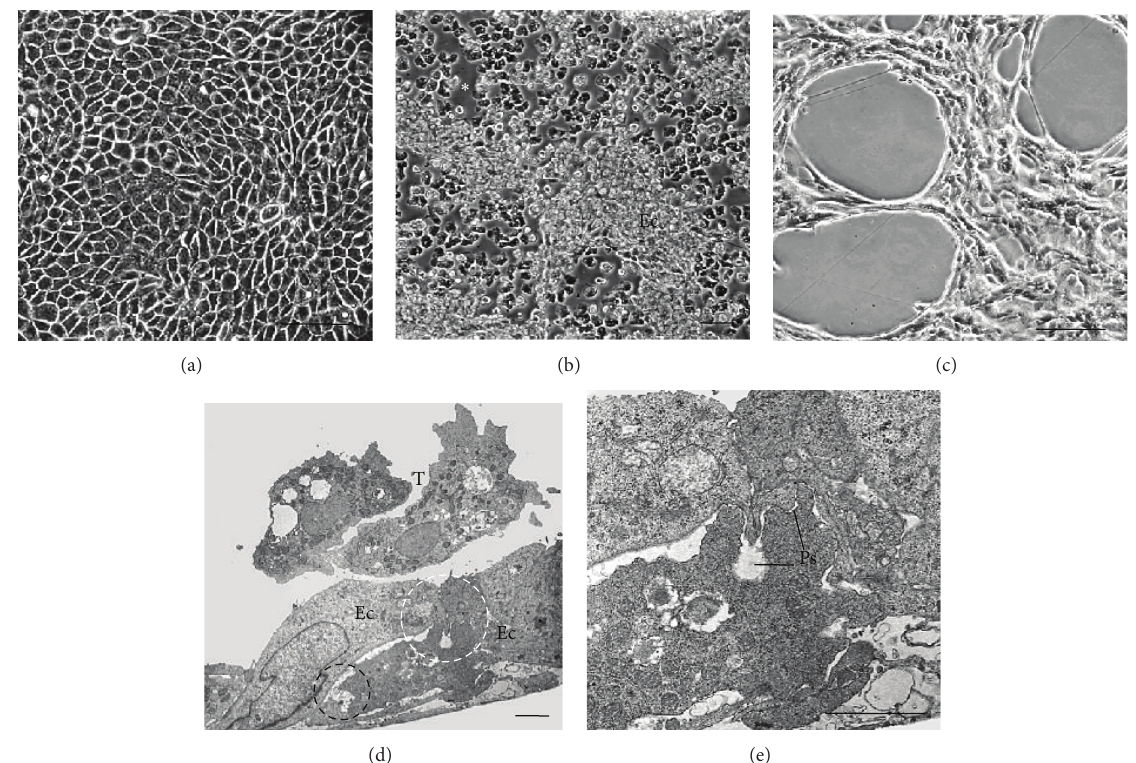
Figure 3: ((a)–(c)) Light microscopy analysis of the interaction between A. griffini trophozoites and MDCK monolayers. (a) Control of MDCK epithelial cells monolayer incubated for 24 h in a mixture of equal proportions of Bacto Casitone and Dulbecco’s modified Eagle’s medium. Note the confluent appearance of the monolayer and the regular morphology of the epithelial cells. Bar = 2.0 𝜇 m. (b) After 24 h of coincubation between trophozoites and the epithelial cells, a noticeable damage is evident. Some areas of the substrate clearly lacking epithelial cells (asterisk) as well as remaining portions of the altered cell monolayer (Ec) are seen. Bar = 1.0 𝜇 m. (c) When MDCK monolayers were incubated with conditioned medium for 24 h rounded areas of varying size missing cells were seen. Bar = 2 𝜇 m. ((d),(e)) Thin sections of coincubations between amoebae and MDCK epithelial cells. (d) Trophozoites (T) were found in close contact with the surface of epithelial cells (Ec) and also under the cell layer. Epithelial cells appear undamaged; nevertheless an amoeba is initiating an injury process (white dotted circle) and is also engulfing cell debris (black dotted circle). Bar = 2 𝜇 m. (e) High magnification of the previous image where two phagocytic structures (Ps) start to engulf a portion of the epithelial cell. Bar = 2 𝜇